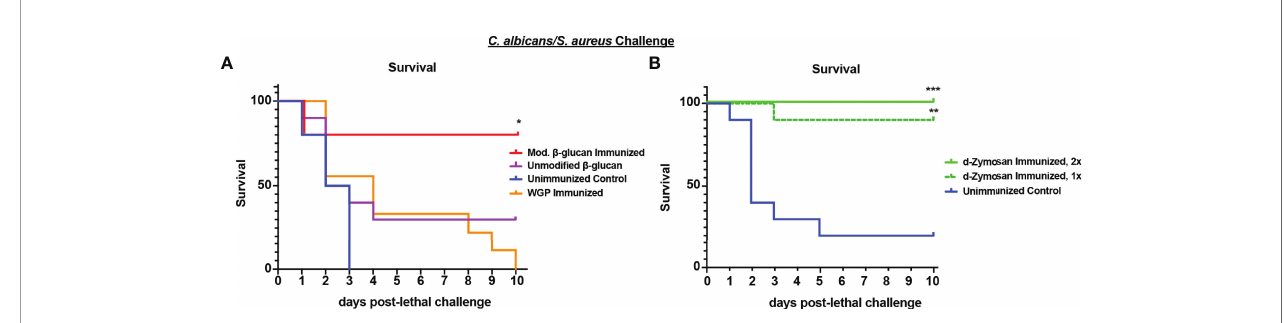
FIGURE 5 | Immunization with b -glucan preparations induces protection against lethal polymicrobial C. albicans/S. aureus IAI. (A) Mice (n=10/group) were immunized by i.p. injection with unmodi fi ed (1 mg), modi fi ed b -glucan (1mg), or whole glucan particle dispersible (WGP, 200 m g) 14 days prior to challenge. (B) Mice (n=10/group) were immunized by i.p. injection with 1 dose (day -14) or 2 doses (day -14, -7) of d-zymosan (1.2 mg) prior to challenge. For lethal IAI challenge, mice were inoculated by i.p. injection with C. abicans (1.75x10 7 CFUs) and S. aureus (8x10 7 CFUs) and monitored for survival and morbidity/sepsis scoring for 10 days. Naïve (unvaccinated) mice served as the negative control. Graphs are representative of 2-3 separate experiments. *, P<0.05; **, P<0.01; ***, P<0.001; ****, P<0.0001 (for values signi fi cantly different from those of the control, by log rank Mantel-Cox test).